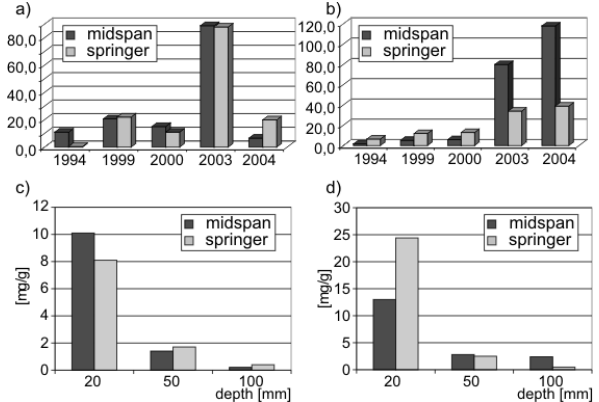
Fig 9. Concentrations of nitrogen salts in surface layer of sandstone block, arch VI – midspan, springer (a); concen- trations of sulphates in surface layer of sandstone block, arch VI – midspan, springer (b); concentrations of NO 3 and SO 4 [ mg/g ] in sandstone blocks of Charles Bridge in relation to trial hole depth, arch III – springer (c); concen- trations of NO 3 and SO 4 [ mg/g ] in sandstone blocks of Charles Bridge in relation to trial hole depth, arch IV – springer (according to Wasserbauer) (d)